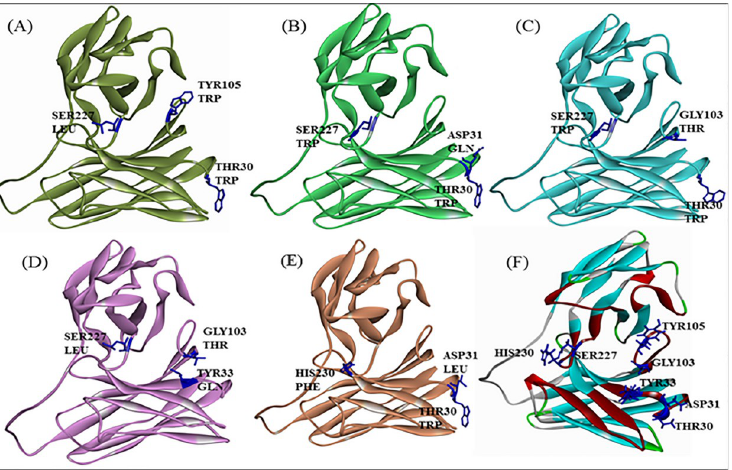
Fig 10. Homology model of triple mutants. Homology model of scFv mutants 1, 2, 7, 8 and 15 from table number 3 are shown as A, B, C, D and E respectively. Mutations of these mutants are shown in dark blue colour. These mutants were compared to homology model of wild type protein shown in (F).